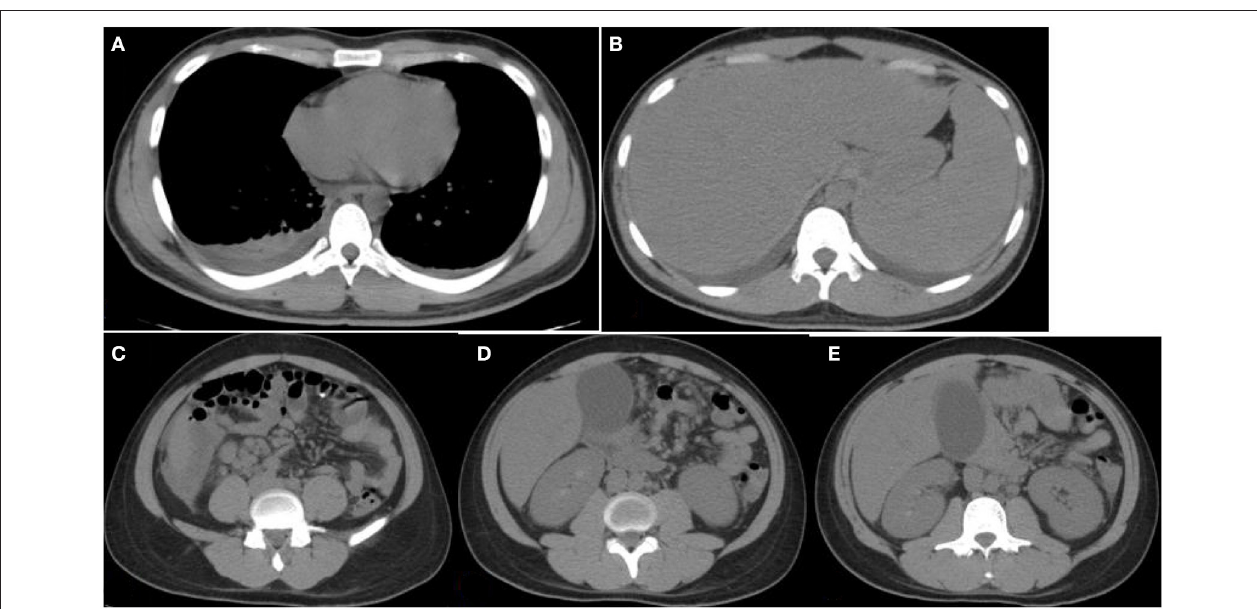
FIGURE 1 | Chest and abdomen computerized tomography (CT) images. CT images obtained at Yuhuangding Hospital showing bilateral pleural effusion (A) , hepatosplenomegaly (B) , fluid collection around the right lower edge of the liver and multiple enlarged lymph nodes in the mesentery of the right lower edge of